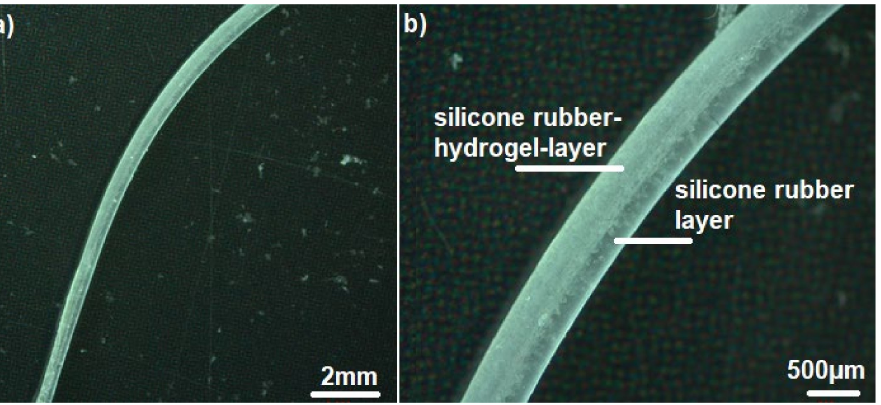
Figure 10. ( a ) Optical microscopy images of sample design C of Nusil Med 4850-PAMAA (25 wt% hydrogel particle size fraction of 48 µm) in dry state deposited on Nusil Med 4850 imitating a CI. ( b ) is an enlargement of image ( a ).